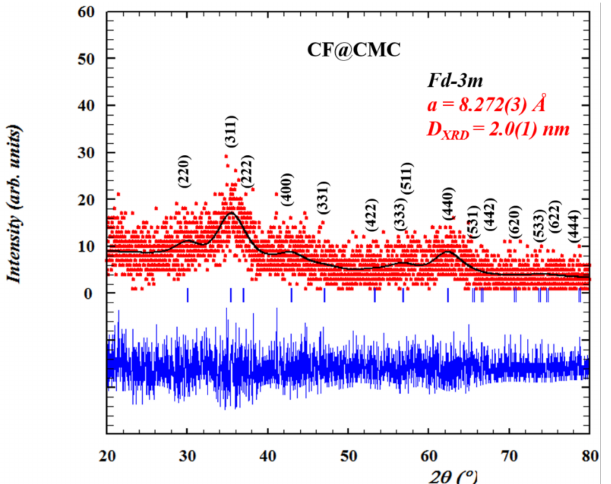
Figure 1. The Rietveld refinement results of CF@CMC magnetic nanobeads. Red points are the experimental data collected at room temperature, black solid line represent the best fits of the experimental data, the vertical blue markers are Bragg peaks positions and the thick blue line represents the differences between the calculated and experimental